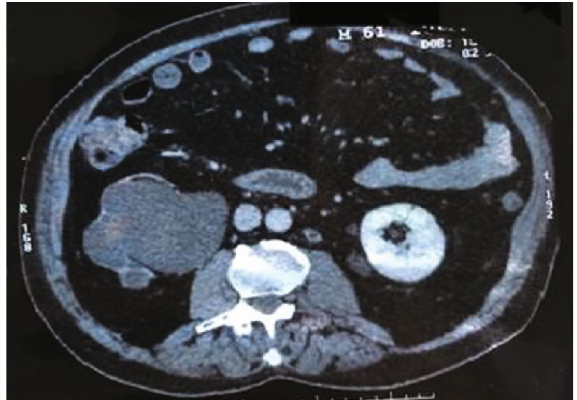
Figure 1: CT of June 2, 2016 showing posteromedial oval image to the left kidney of 2,4cm.